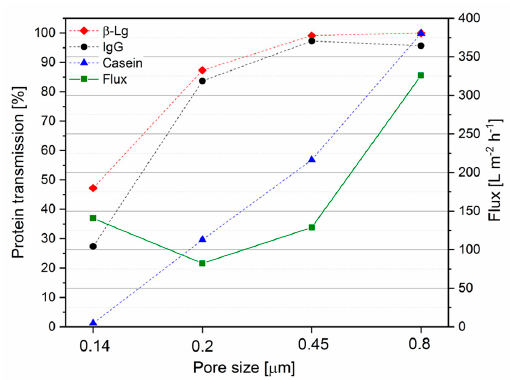
Figure 3. IgG and casein transmission as well as flux function at different pore sizes using ceramic standard membranes at a steady state flux after 90 min of filtration at 50 °C. For time dependent data, see Supplementary Data.